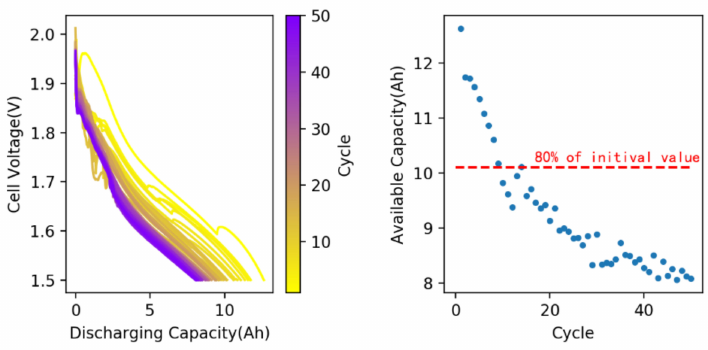
Figure 2. The discharging curves and capacity fading process of cell #1.